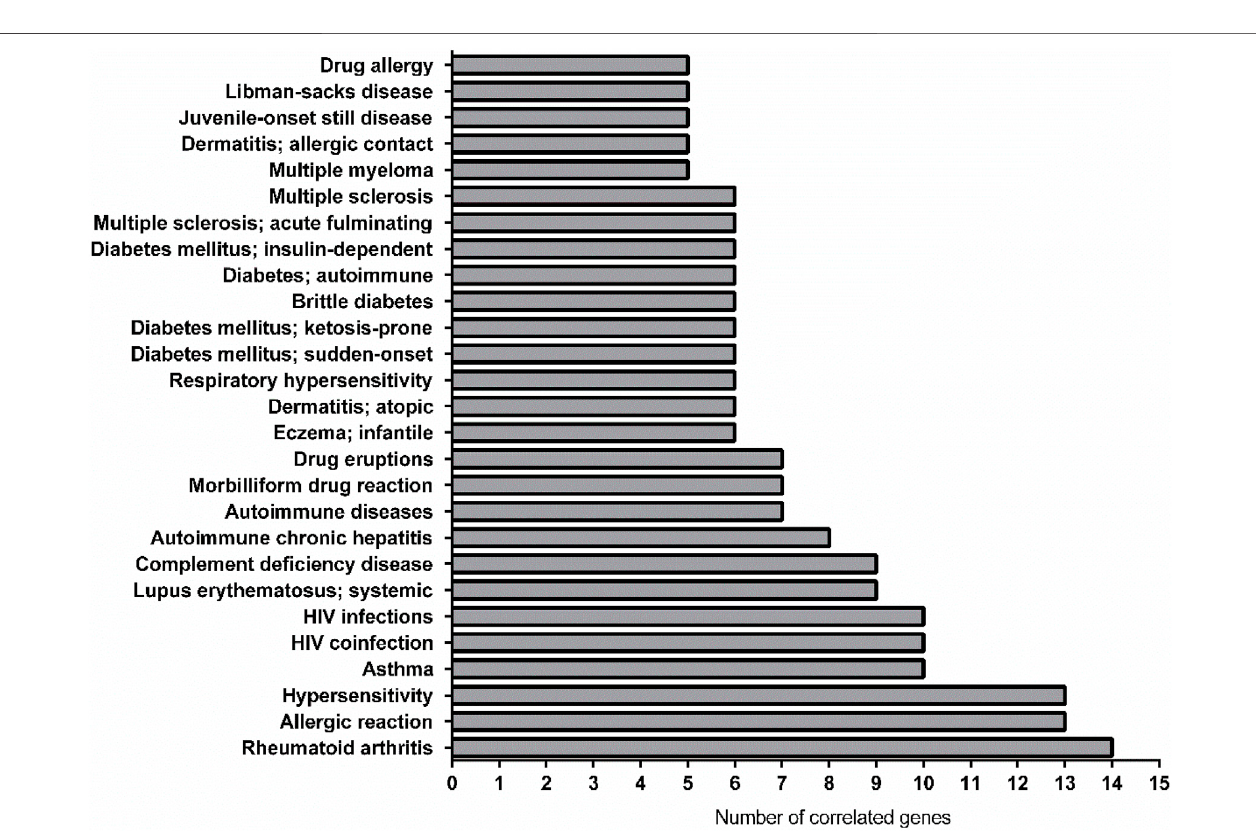
FIGURE5 | Graphical representation of themost linked immune system diseases with thegene list in CURDi. The highest number ofcorrelated genesare found in rheumatoid arthritis (14 linked genes), allergic reaction and hypersensitivity (13 linked genes) and asthma (10 linked genes).